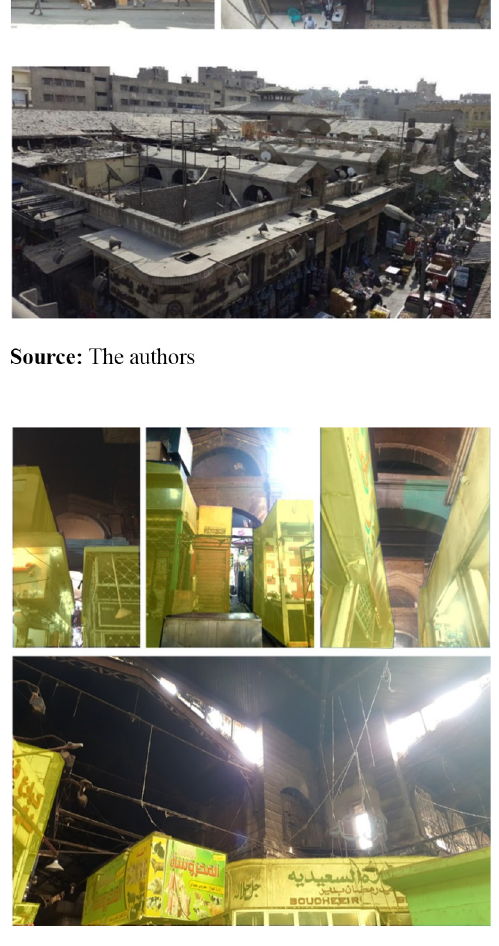
encroachments, Attaba market, Cairo